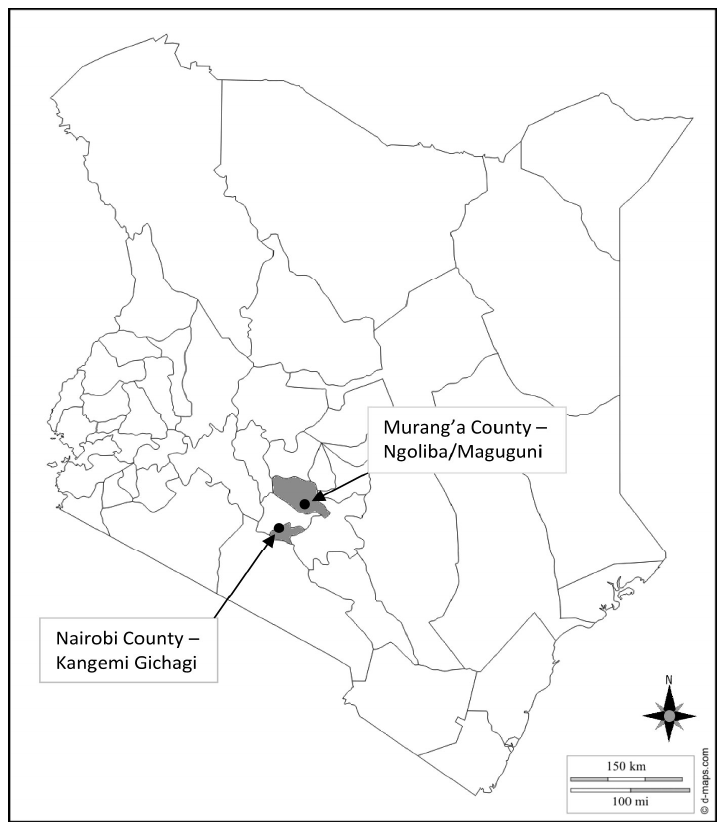
Figure 2. Administrative map of Kenya showing the study areas [32]. Due to changes in the